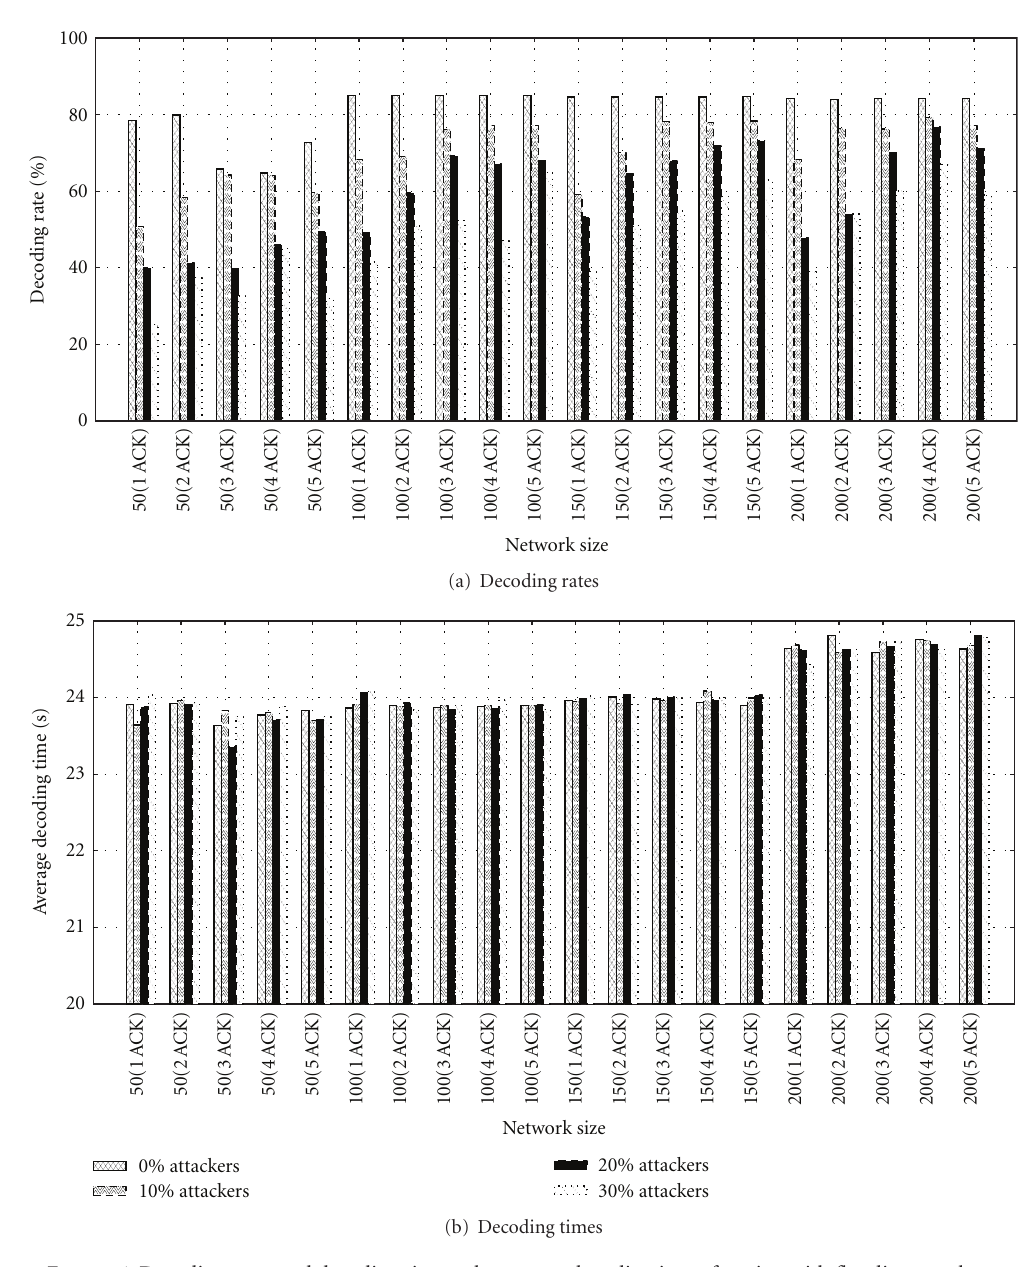
Figure 6: Decoding rates and decoding times when network coding is confronting with flooding